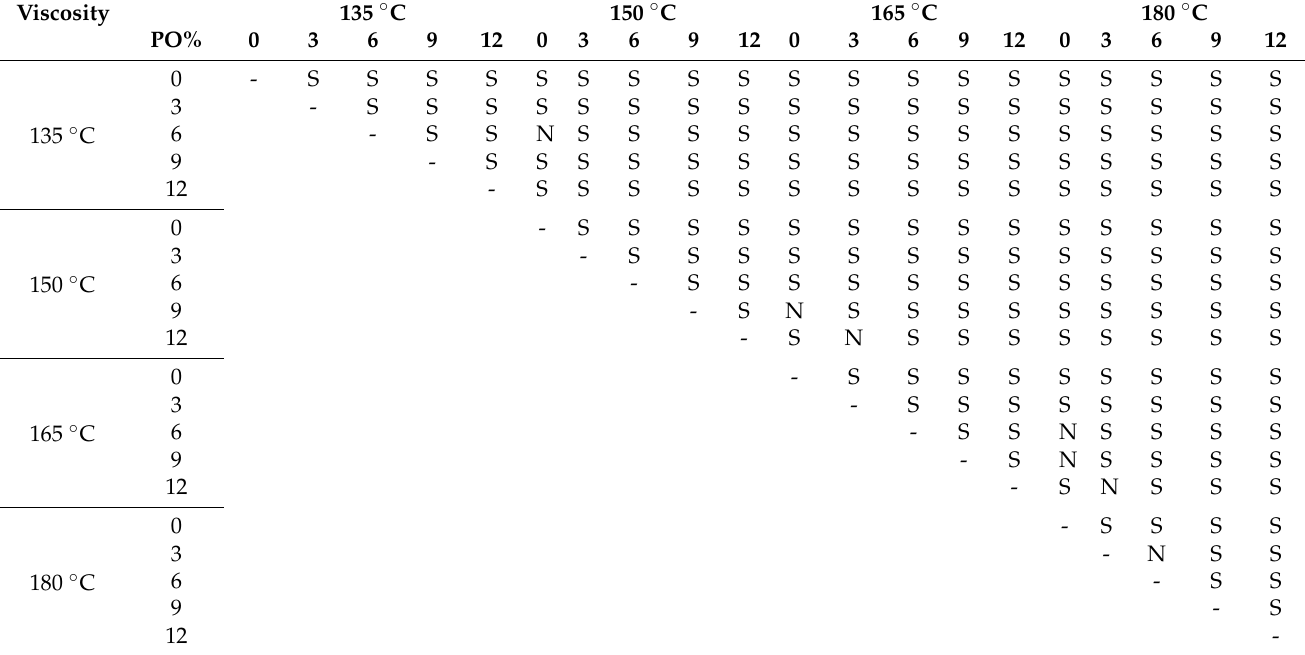
Table 3. Statistical analysis results of the RV test for PG 64-22 as a function of processed oil content ( α = 0.05). Viscosity